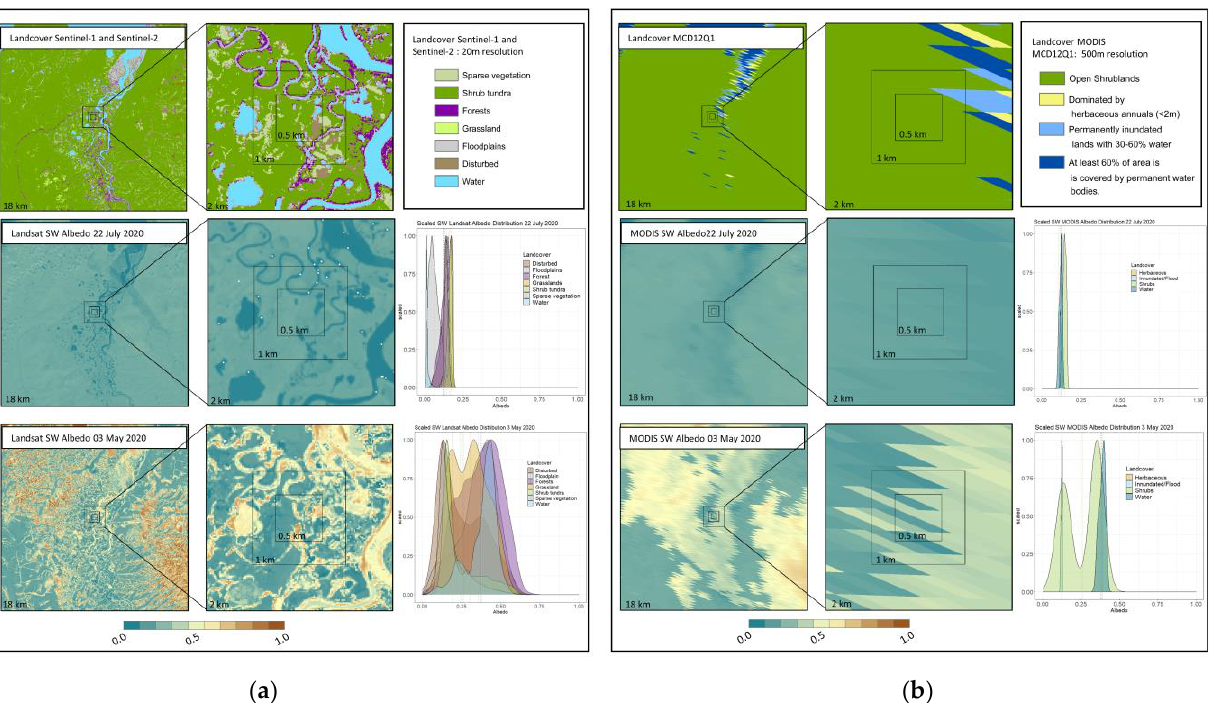
Figure 6. Comparison of Landsat ( a ) and MODIS ( b ) albedo results of varying landcovers on the northern edge of the Seward Peninsula, Alaska USA. Imagery from mid-summer (22 July 2020—middle row) and the early spring (03 May 2020—bottom row) show the landscape in the presence and absence of snow. The 18 km subsets highlight the heterogeneity of the region as a whole as captured by the Landsat-scale albedo and landcover results. The 2 km subsets and coincident density estimations of albedo show the increase in information available using higher resolution imagery. The range in albedo values is greater in both higher resolution plots and clear separation in albedo signature can be seen in the landcovers presented here.